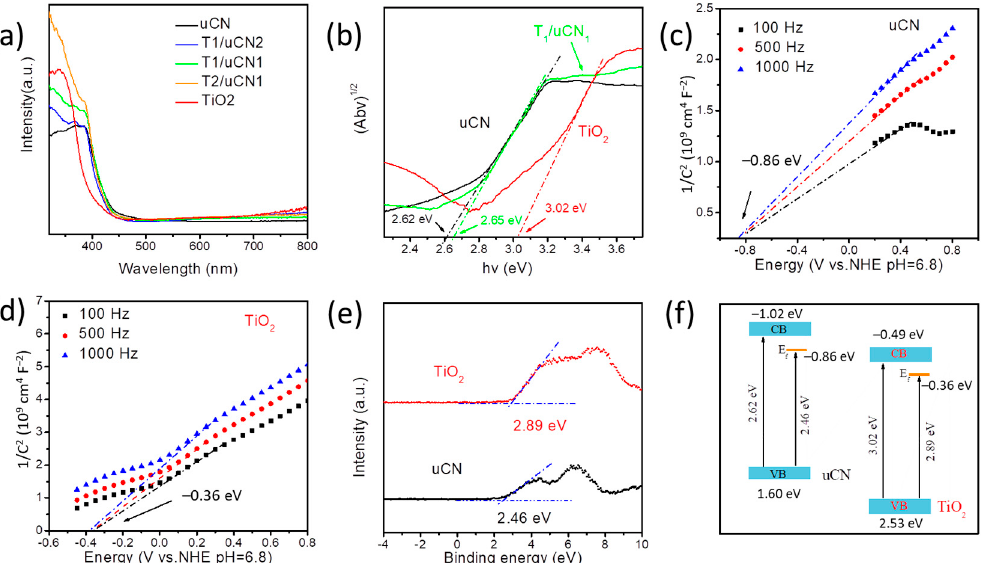
Figure 4. ( a ) UV-vis absorption spectra. ( b ) Kubelka–Munk-transformed function of TiO 2, uCN and T 1 /uCN 1 . ( c , d ) Mott–Schottky plots of uCN ( c ) and TiO 2 ( d ). ( e ) Valence band XPS spectrum of TiO 2 and uCN. ( f ) Diagram of the band structure of TiO 2 and uCN.